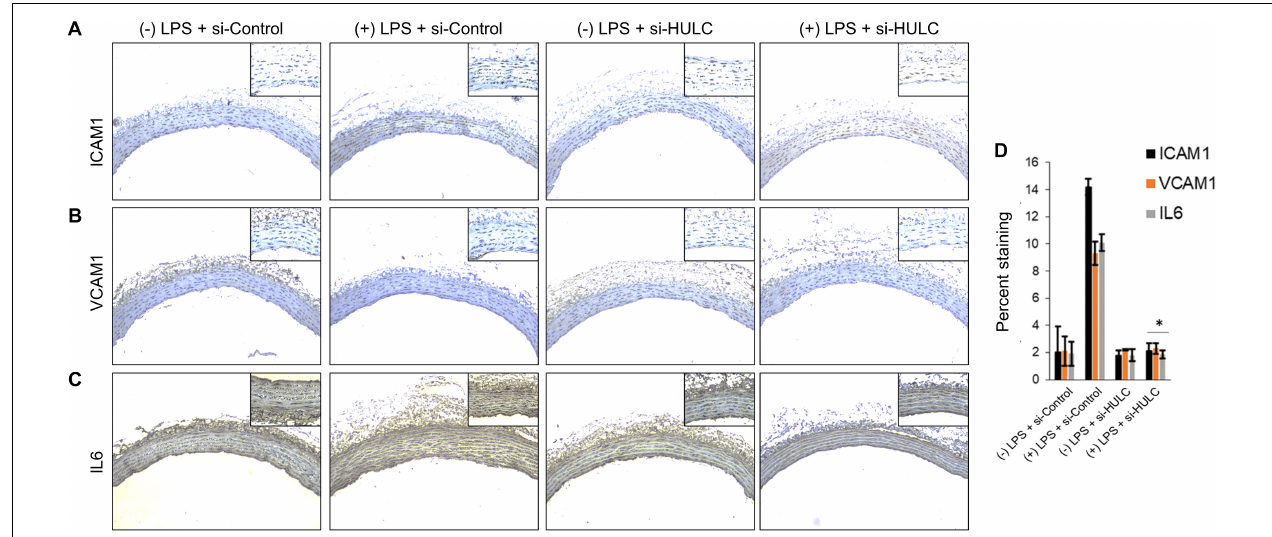
FIGURE 6 | Downregulation of HULC using siRNA inhibits sepsis associated induction of ICAM1, VCAM1, and IL6 in vivo . The aorta was isolated and the expression levels of ICAM1, VCAM1, and IL-6 were detected by immunohistochemical staining with IHC. Shown are representative images obtained at 100 × magnification (inset 400 × magnification) of aortic tissue in indicated experimental groups stained with antibody against (A) ICAM1, (B) VCAM1, and IL6 (C) . (D) Quantification of images obtained from 6 animals of each experimental group. ∗ P < 0.05, compared to corresponding specimen in +LPS + siRNA-scramble control